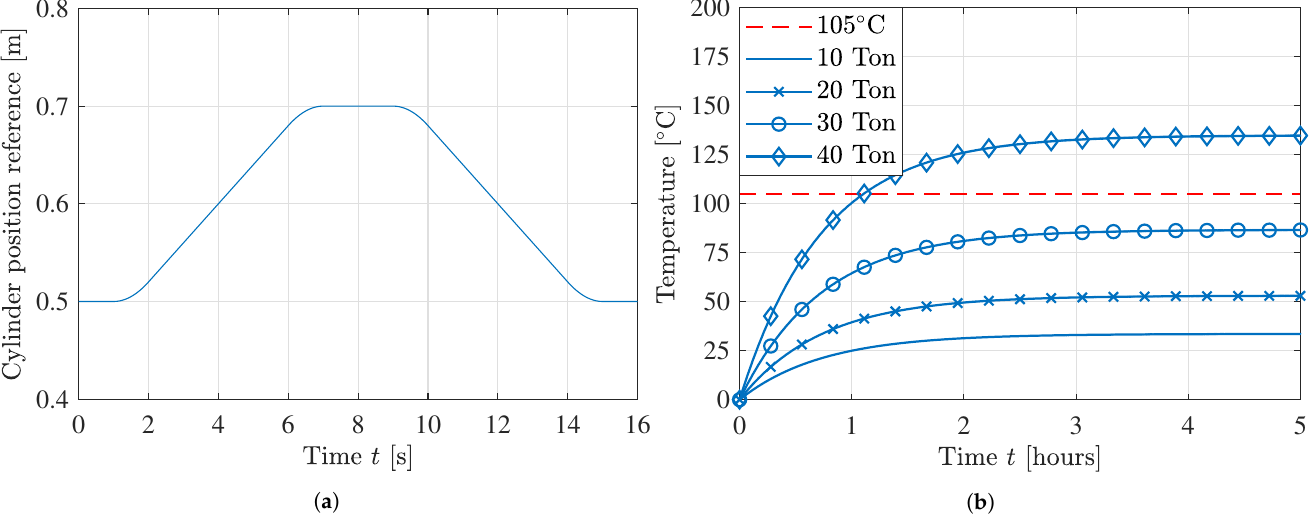
Figure 21. Position reference and temperature for the load cycle running repeatedly for 5 h. ( a ) Position reference; ( b ) Temperatures with different